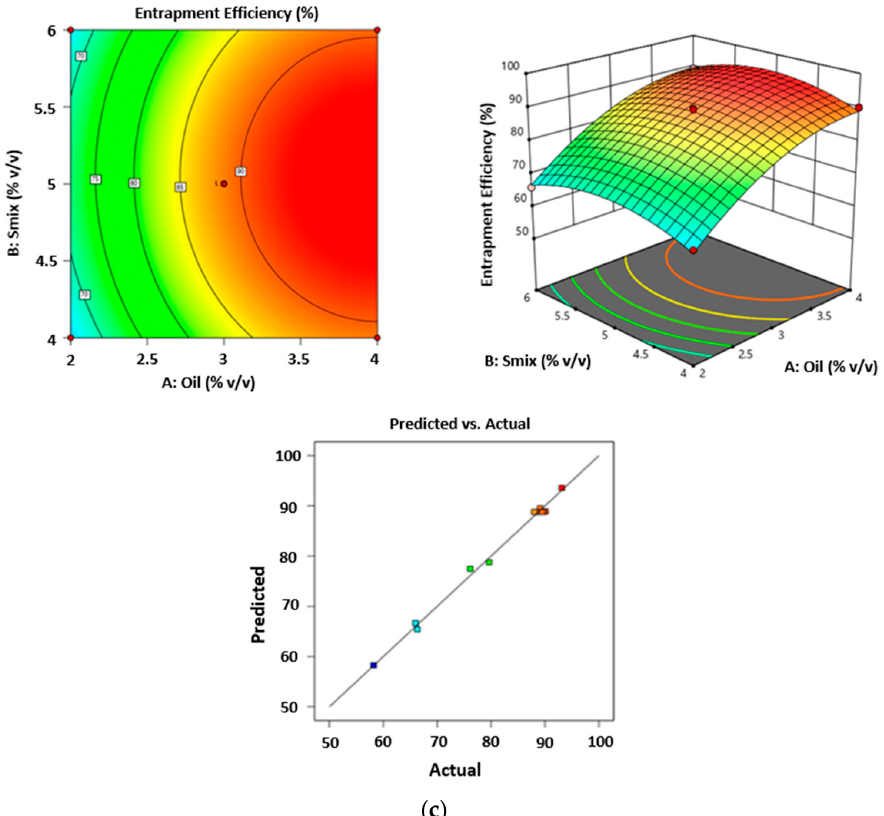
Gels 2022 , 8 , x FOR PEER REVIEW Figure 3. 3D Response surface graphs showing the effect of oil and Smix concentration on ( a ) Particle Size (nm), ( b ) Zeta Potential (mV) and ( c ) Entrapment Efficiency (%EE). Table 1. Responses obtained using CCRD.